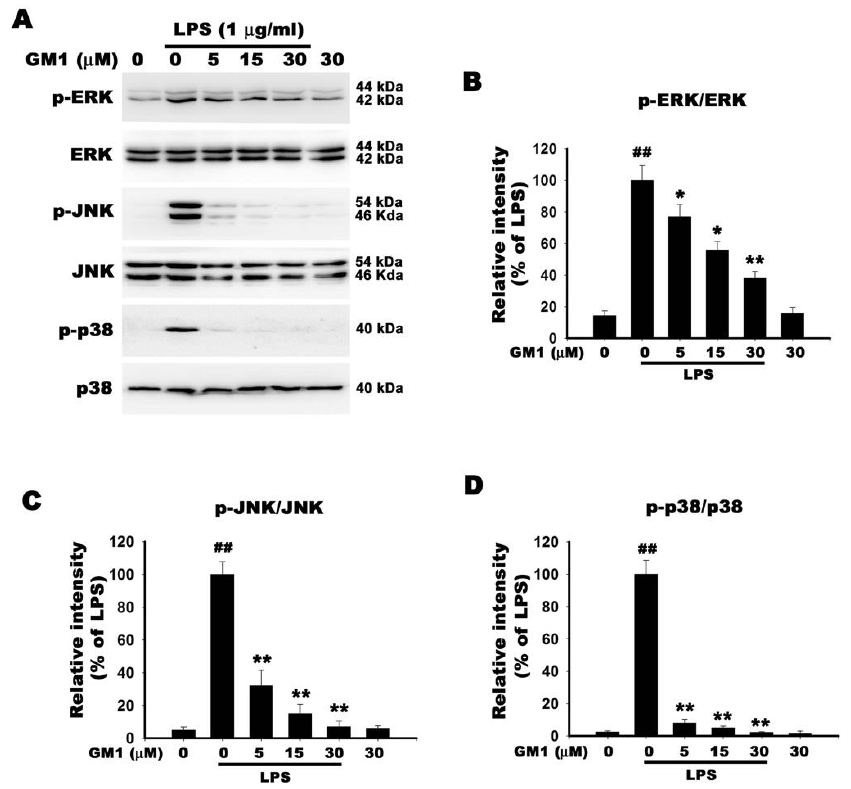
Figure 9. Effect of GM1 on MAPK activation in LPS-stimulated RAW 264.7 cells. ( A ) Cells were pretreated with various concentrations of GM1 (5, 15, 30 μM ) for 1 h and then stimulated with LPS (1 μg/mL) for 1 h. Cell lysates were subjected to Western blotting to determine levels of MAPK proteins (p-ERK/ERK, p-JNK/JNK and p-p38/p38). ( B - D ) Quantitative analysis of MAPK protein levels. Data are presented as percentages relative to the LPS group (mean ± SD, n = 3). ## p < 0.01 compared with the control group; * p < 0.05 and ** p < 0.01 compared with the LPS treatment group.